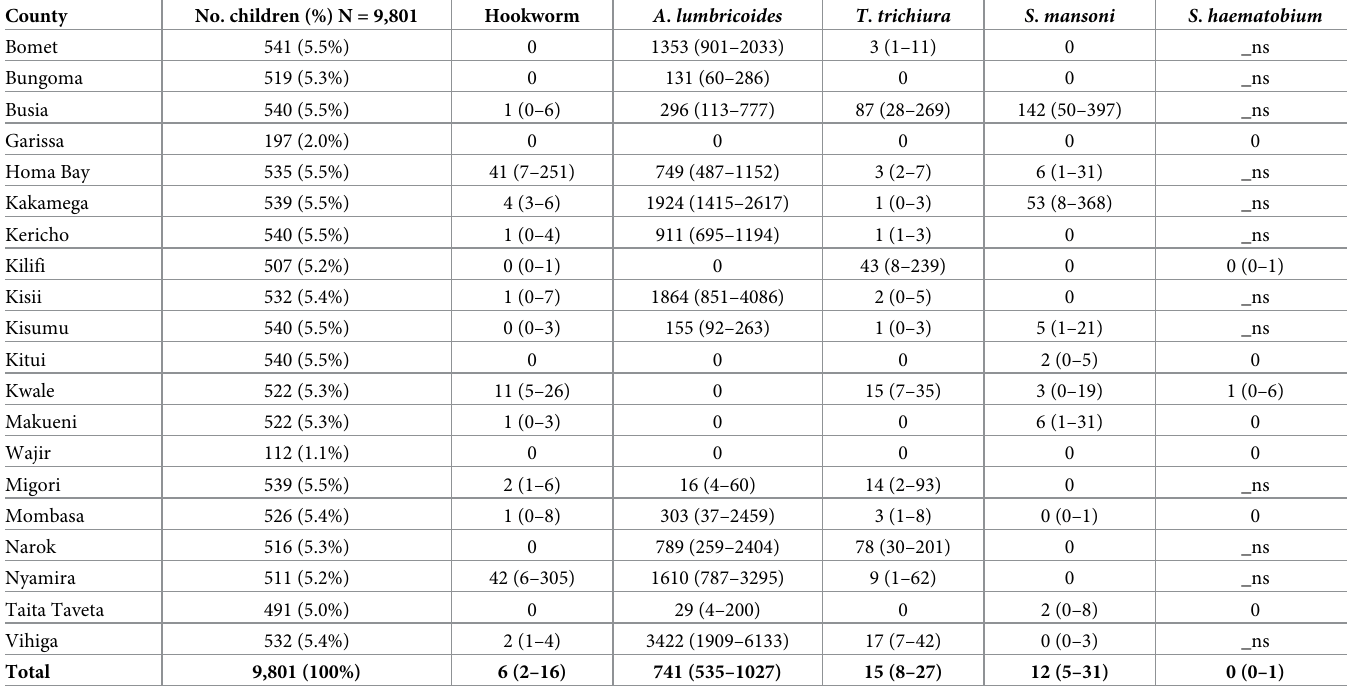
Table 5. Overall and county mean intensity epg (95%CI) for STH and schistosomiasis among school children in Kenya after five rounds of MDA.